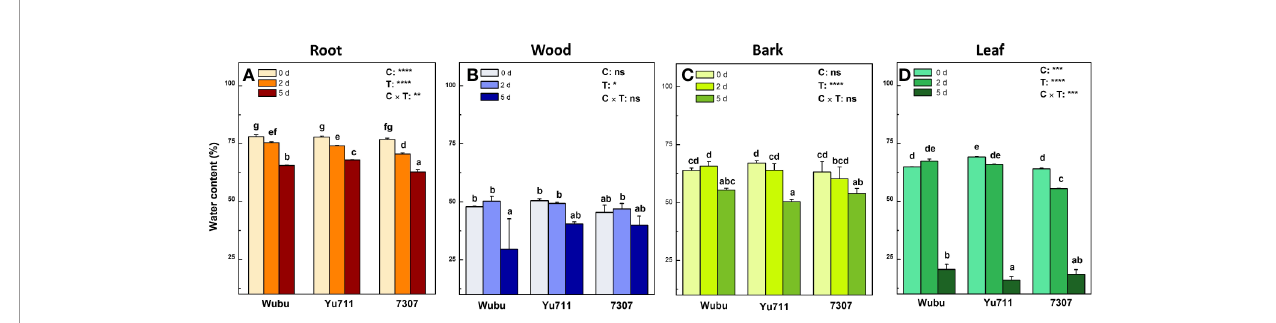
FIGURE 1 | Water contents in roots (A) , wood (B) , bark (C) , and leaves (D) of mulberry cultivar Wubu, Yu711, and 7307 exposed to progressive drought stress for 0, 2, and 5 days (denoted as 0 d, 2 d, and 5 d), respectively. The bar indicates mean ± SE (n = 6). Different letters on the bars indicate signi fi cant difference. ANOVAS of cultivars (C), time (T), and their interaction (C × T) are also indicated. * P < 0.05; ** P < 0.01; *** P < 0.001; **** P < 0.0001; ns, not signi fi